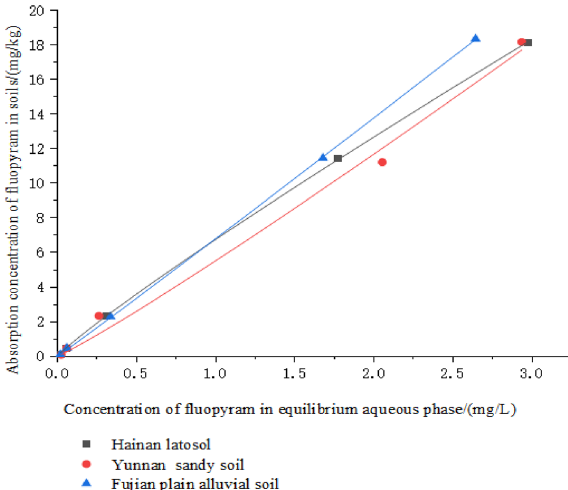
Figure 5. The adsorption isotherms of fluopyram in three types of